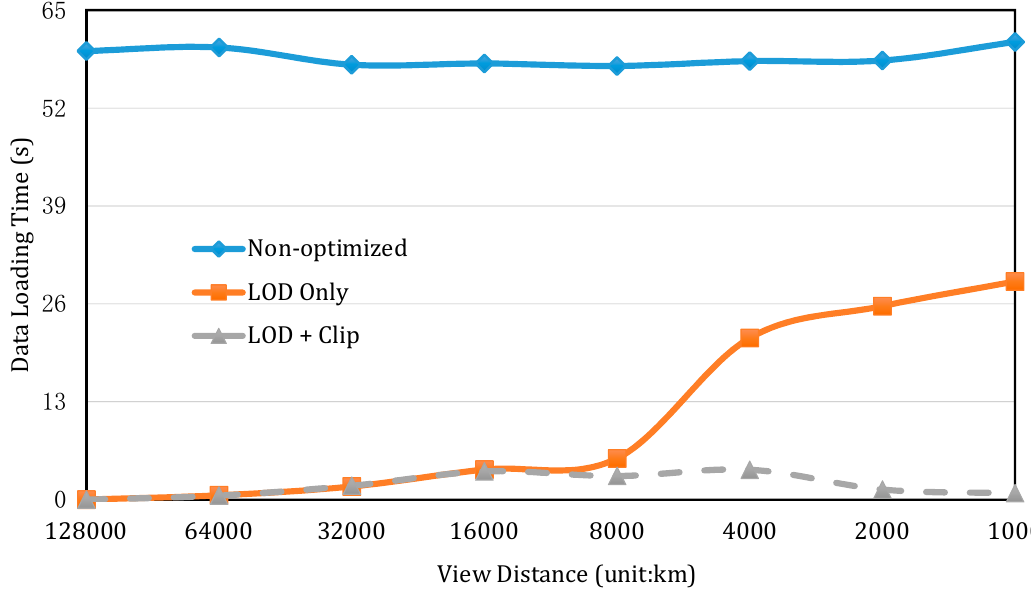
Figure 6. Comparison of data loading time before and after applying optimization strategies as the view distance becomes shorter. (Error bars are smaller than the plot markers).